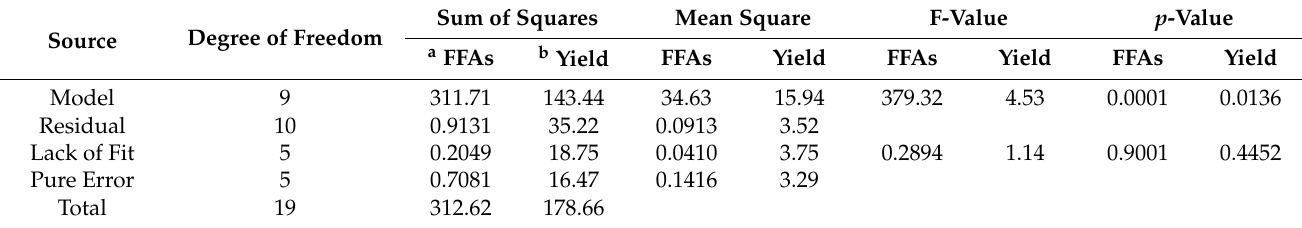
Table 4. Analysis of the variance (ANOVA) of the response surface quadratic